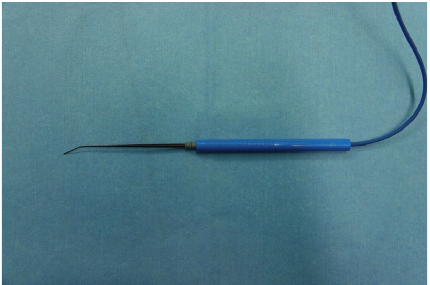
Figure 2: Conventional